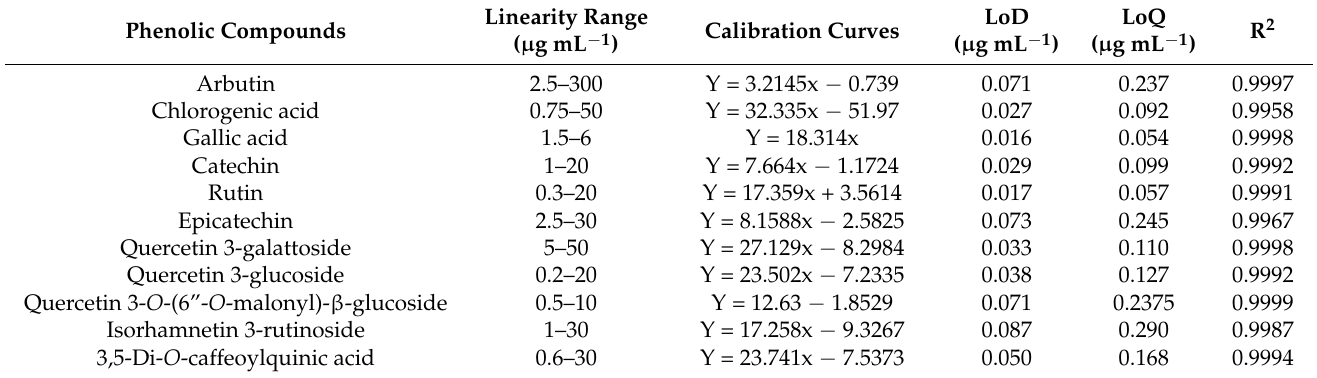
Table 9. Chromatographic parameters of the quantitative evaluation of the phenolic compounds. Phenolic